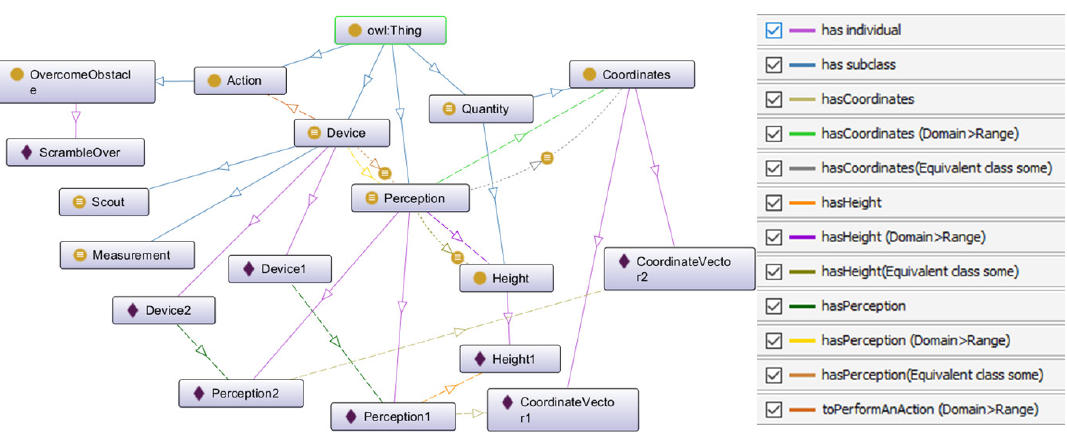
Figure 1. Example of robot ontology.